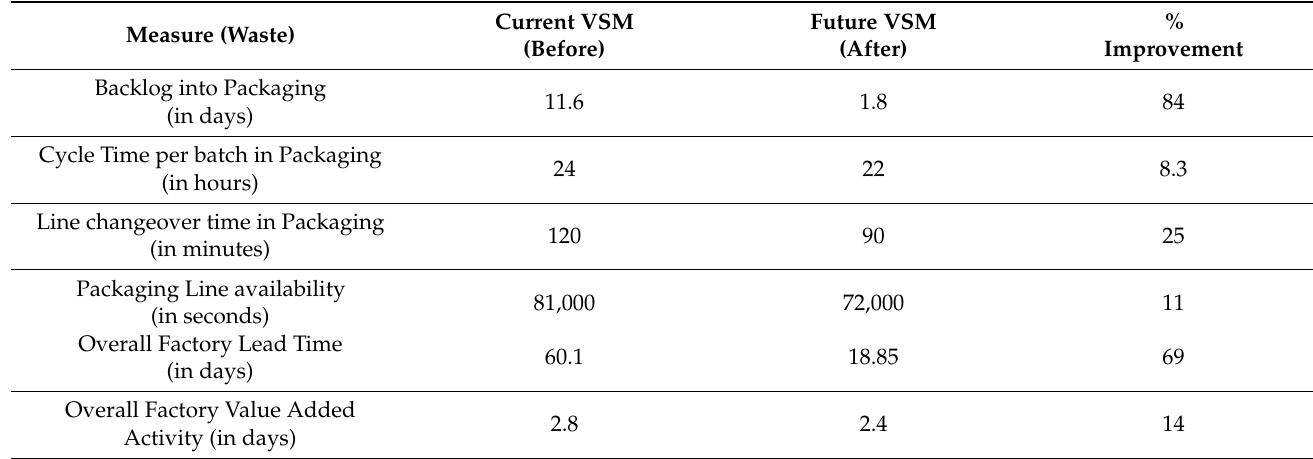
Figure 21. “Future” Value Stream Map. Table 5. Current VSM metrics vs. Future VSM